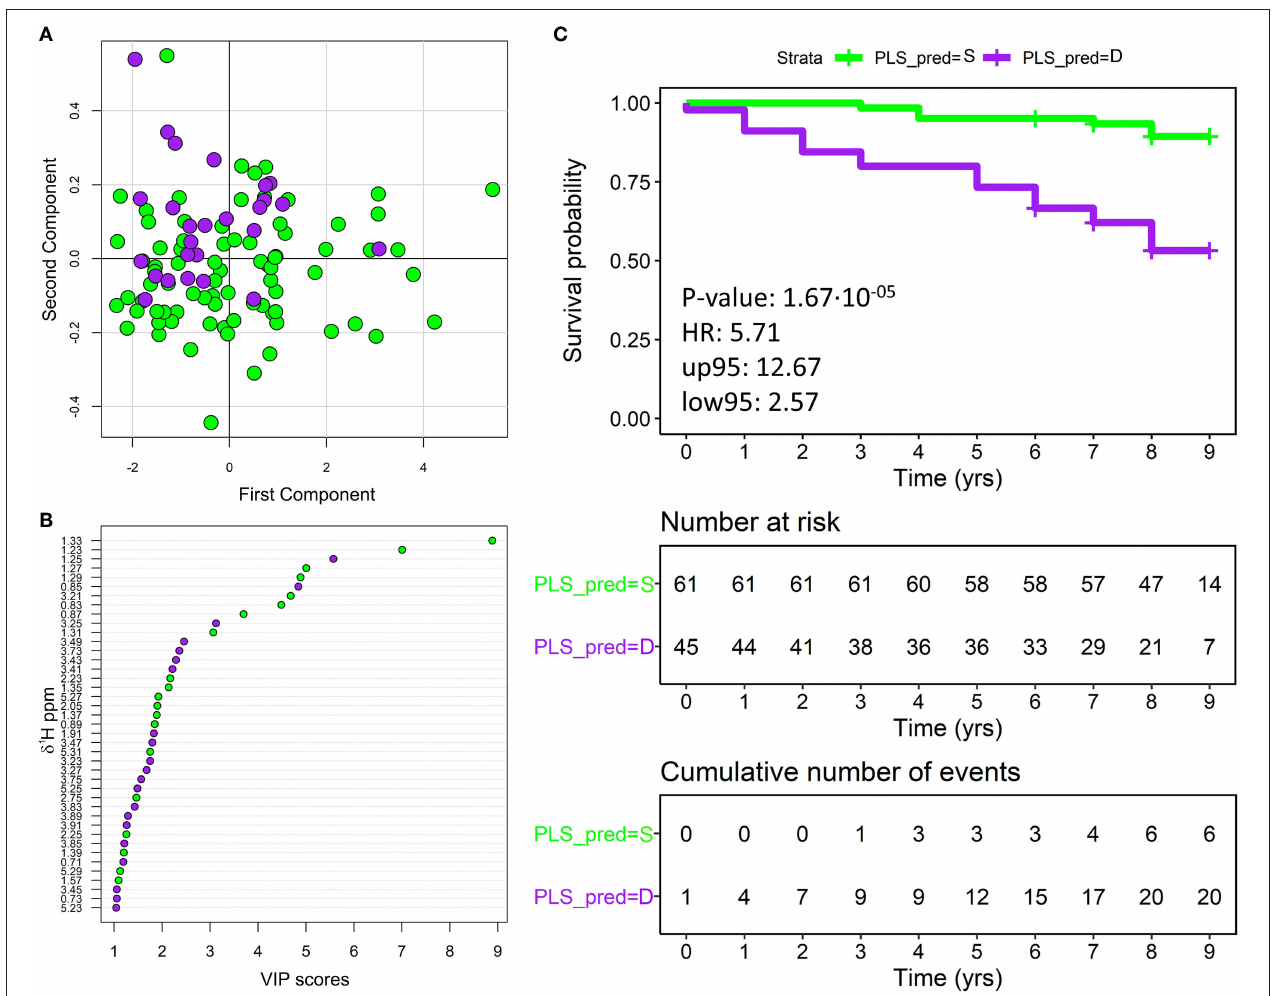
FIGURE 2 | (A) score plot of the first two components of the partial least square discriminant analysis (PLS-DA) model discriminating survivor (80 green dots) and deceased (26 purple dots) patients. (B) The variable importance in projections (VIP) score plot indicating the most discriminating bins in descending order of importance; only the bins that showed a VIP score > 1 are reported in the plot. For each bin the starting ppm is reported. Green dots represent bins with intensity higher in survivor patients, conversely purple dots represent bins with intensity higher in deceased patients. (C) Overall patients with HF, plotting actual survival over time (in years) according to estimated metabolomic risk [Kaplan-Meier (KM) curves]. Low metabolomic risk (green) and high metabolomic risk (purple) patients are significantly clustered with a p -value of 1.67 · 10 − 5 (calculated with the Log-Rank test) and an HR of 5.71. Censored events represent either the time of last recorded clinical follow-up, or the time of death. Number at risk: number of patients stratified according to the metabolomics classification at each time point. Cumulative number of events: total number of deceased patients at each time point for each metabolomics risk group. PLS_PRED = S, predicted by PLS as survivor; PLS_PRED = D, predicted by PLS as